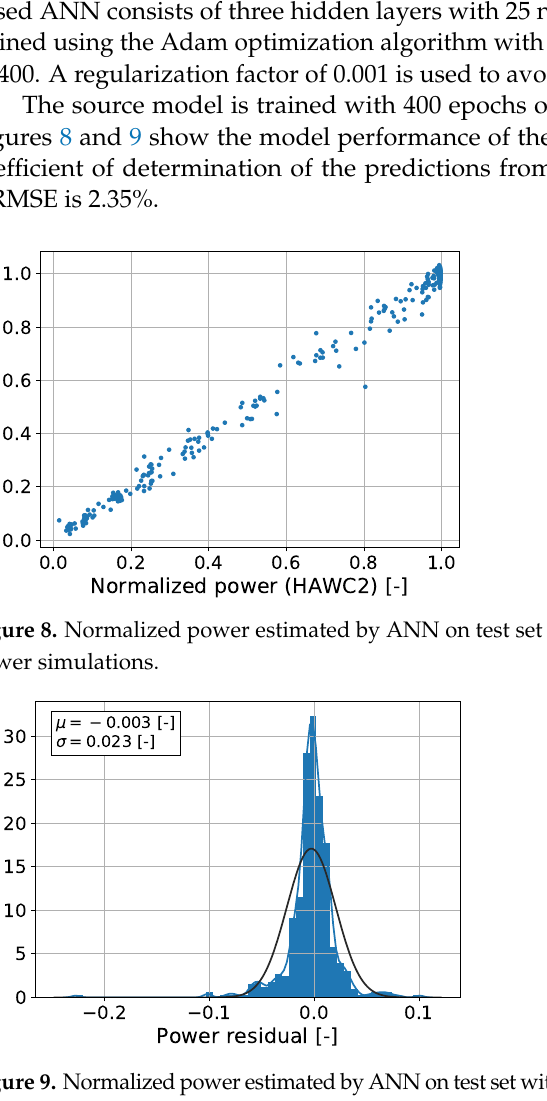
Figure 9. Normalized power estimated by ANN on test set with respect to normalized power